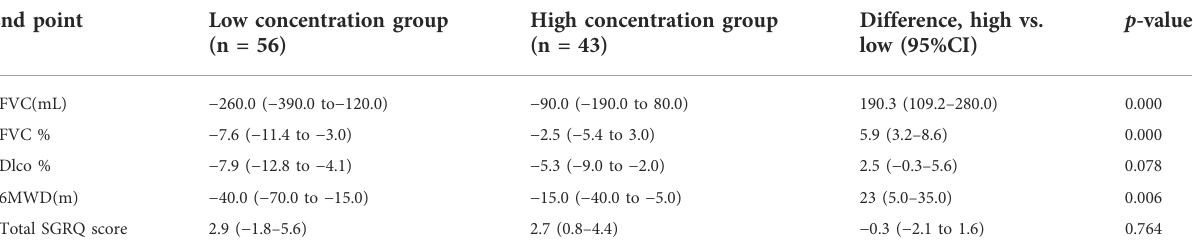
TABLE 2 Ef fi cacy